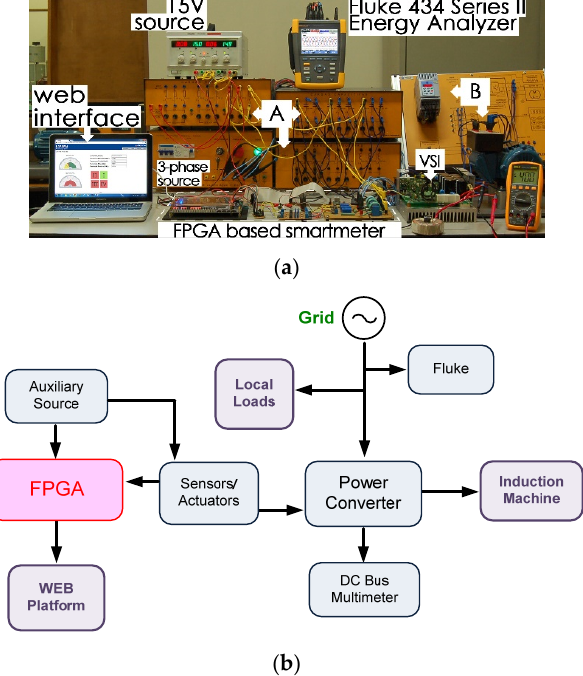
Figure 19. Test bench for smart meter compensation with web interface. ( a ) Experimental setup; ( b ) test bench block scheme.